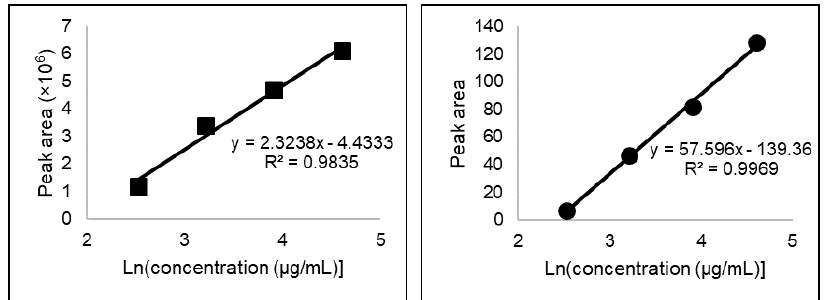
Figure 2. Plot of standard calibration of quercetin (left) and gallic acid (right).